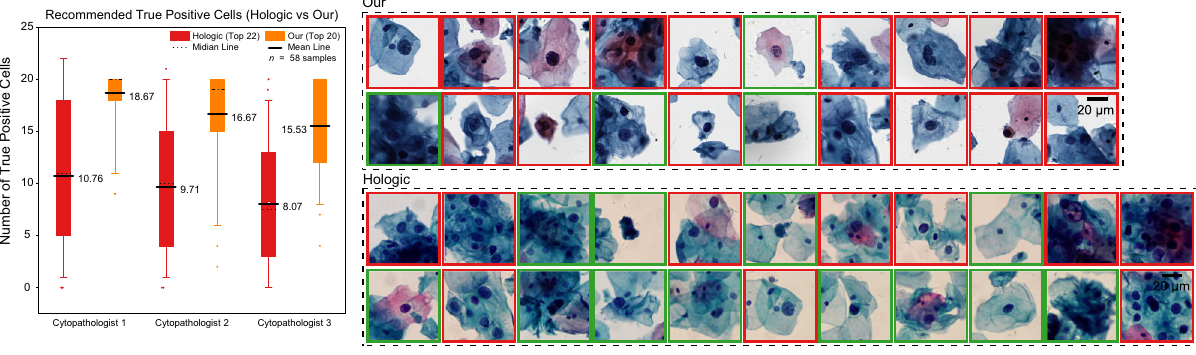
Fig. 5 Comparison of our system and Hologic TIS on recommending top lesion cells. The histogram on the left shows the true positive cell number of our system ’ s top 20 cell regions (about 60 × 60 μ m 2 ) and TIS ’ top 22 fi elds of view (far greater than 60 × 60 μ m 2 ) on 58 positive slides ( n = 58). The boxes indicate the upper and lower quartile values, the whiskers indicate the 95% and 5% quantile values, the middle bold solid line and dotted lines indicate the mean and median values, and the scatter dots indicate outliers. The subgraph on the right is recommended cells of one positive slide. Notably, the most suspicious cells were cropped from TIS ’ top 22 fi elds of view according to cytopathologists ’ evaluation results. The cells with the red border line were evaluated as true positive cells by training datasets were used, the AUC values of the mined, base- line, and HR models increased gradually from 0.808 to 0.983. The results indicate that the diverse data learning of multiple groups with different styles is important for model generalization.